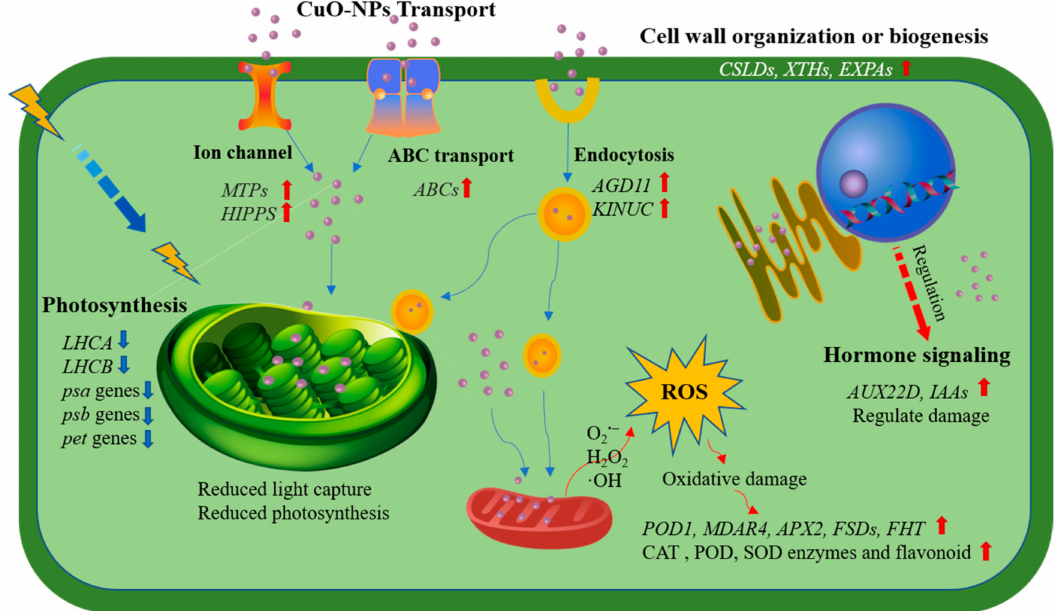
Figure 8. The scheme of lettuce responses to CuO-NPs. The CuO-NPs and Cu 2+ mainly uptake and transport by ABC family, endocytosis/phagosome (upregulate AGD11, KINUC. etc), HIPPs, MTPs, and metal ion channel; CuO-NPs could have damaging effects on photosynthesis and led to oxidative damage; The increase of antioxidant activity (CAT, POD, and SOD activity and flavonoids content), and the upregulate of cell wall organization or biogenesis genes (CSLDs, XTHs,